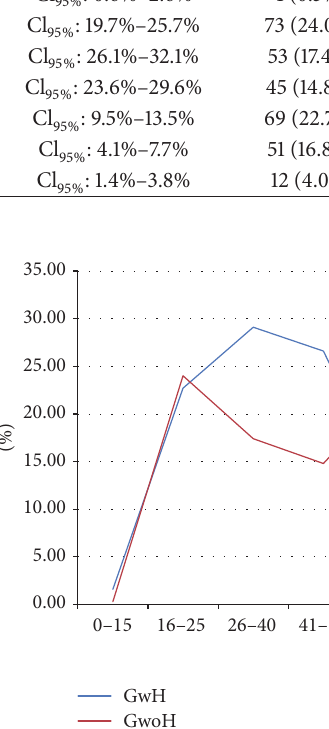
Figure 1: Line chart of frequency distribution for age intervals in Group with Headache (GwH) and Group without Headache